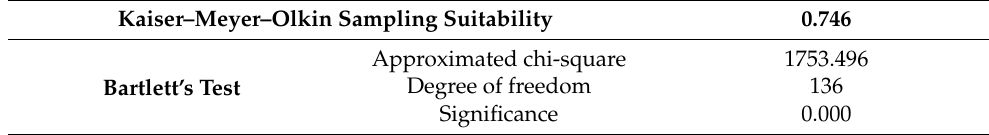
Table 9. Kaiser–Meyer–Olkin and Bartlett’s test.